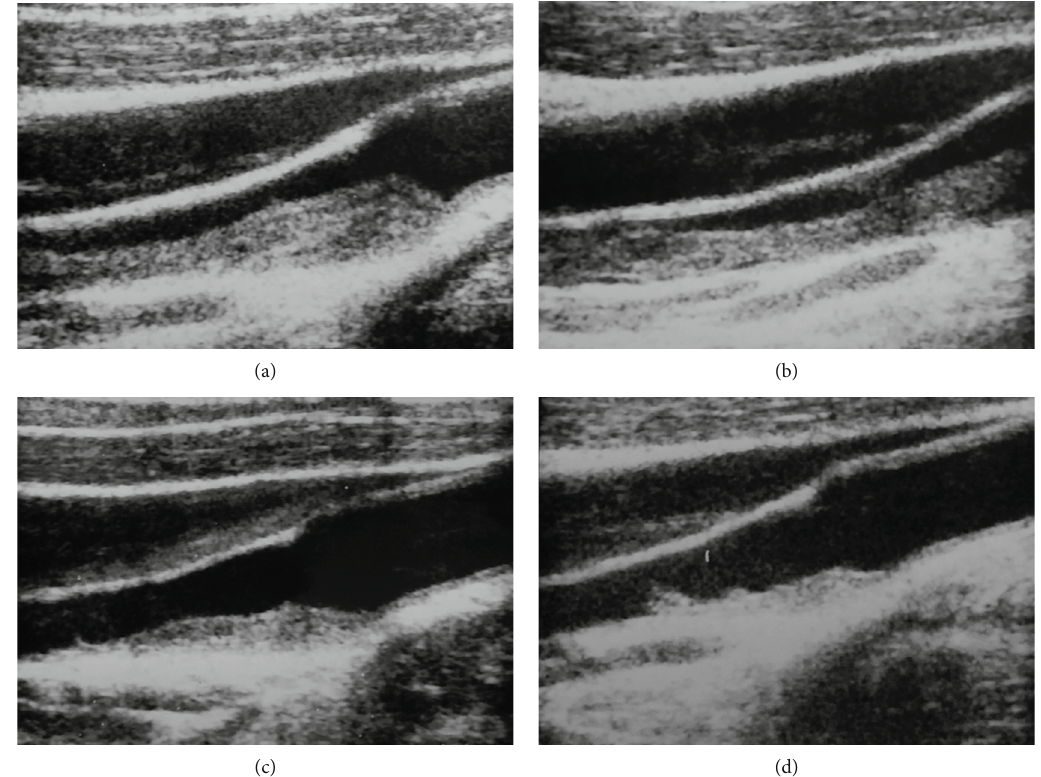
Figure 1: (a, b) A huge homogeneous soft plaque with irregular surfaces and circumferential blood fl ow at the distal end along carotid bifurcation. (c) Image at 1 week after starting therapy. (d) Image at 2 weeks after